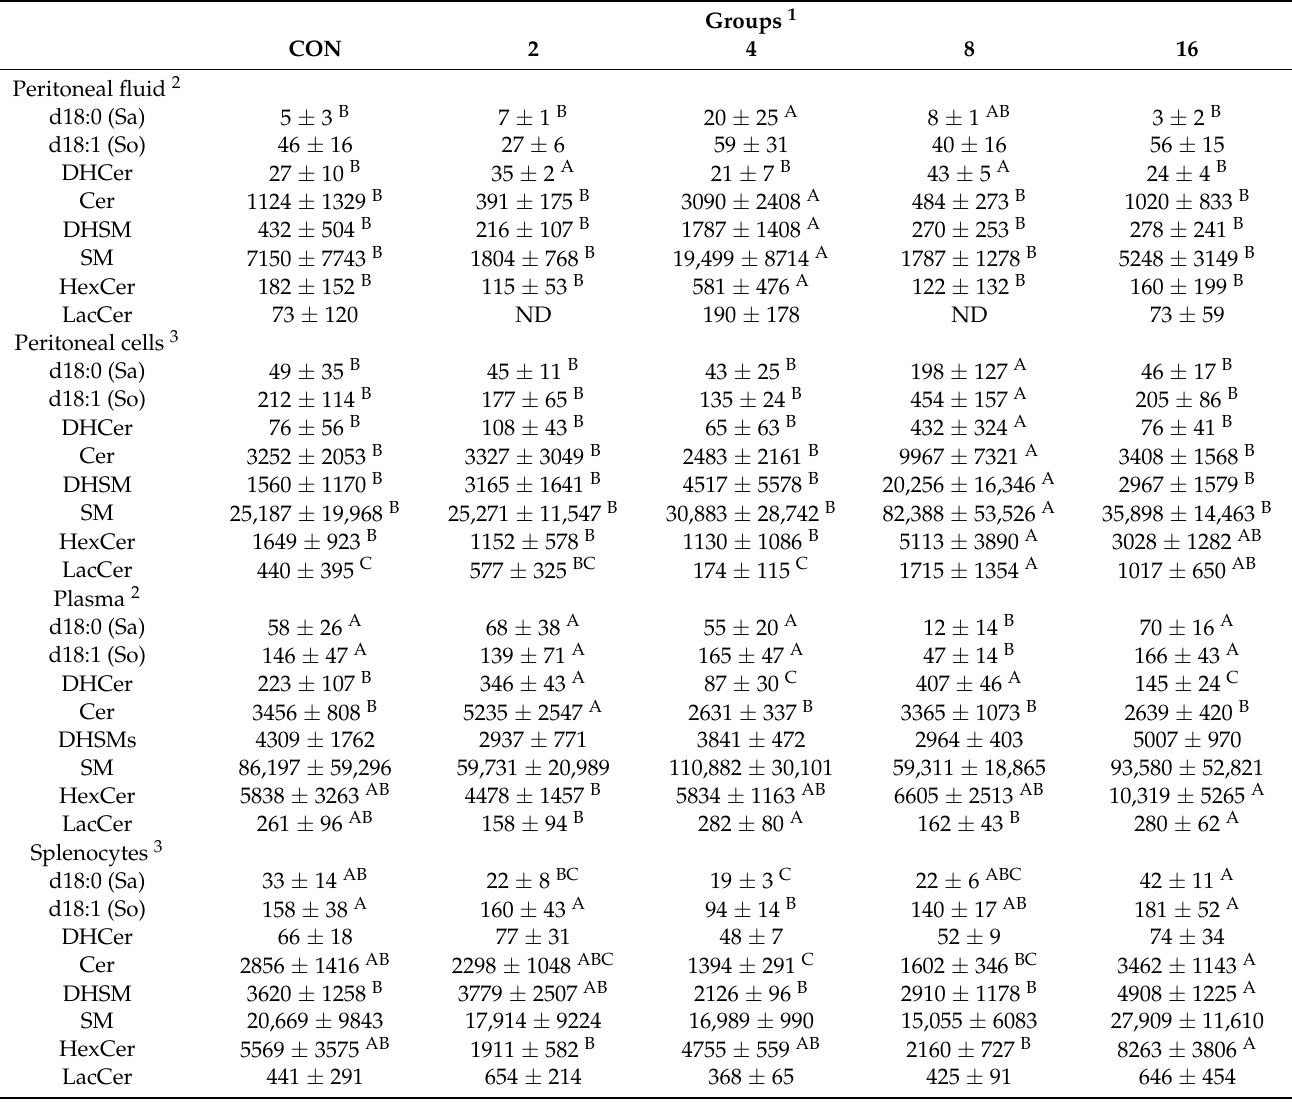
Table 2. Concentrations of sphinganine, sphingosine, dihydroceramides, ceramides, dihydrosphin- gomyelins, sphingomyelins, monohexosylceramides, and lactosylceramides measured in the peri- toneal fluid, peritoneal cells, plasma, and the spleens of mice injected with zymosan or PBS. Groups 1 CON